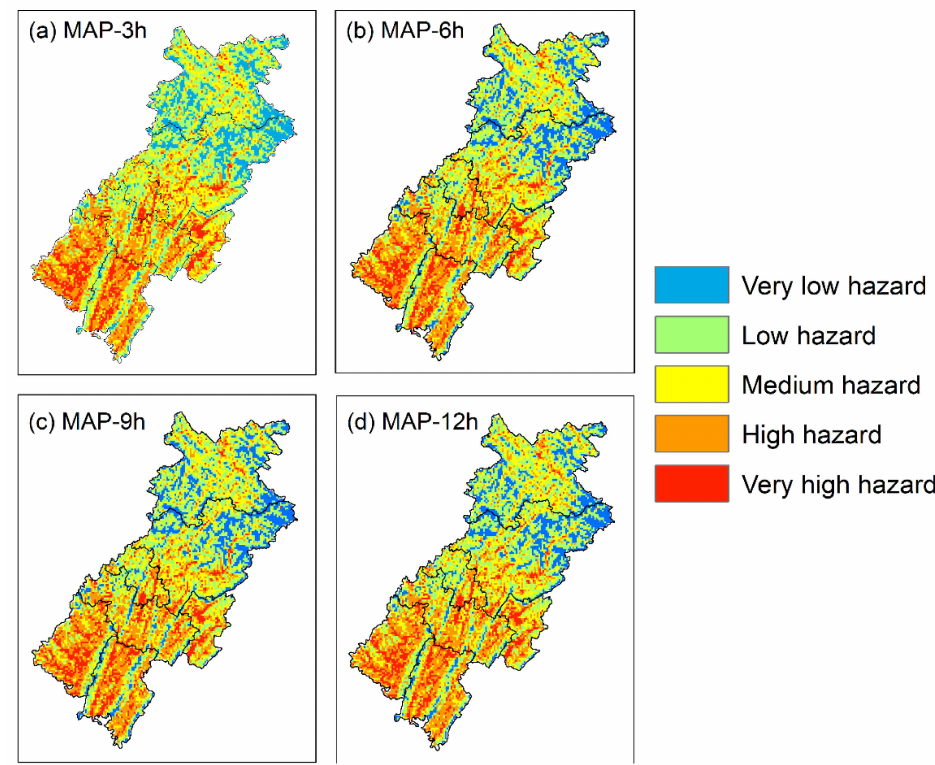
Figure 8. Flood hazard distribution map in Dazhou City under four rainfall durations. ( a ) MAP-3 h; ( b ) MAP-6 h; ( c ) MAP-9 h; ( d ) MAP-12 h.